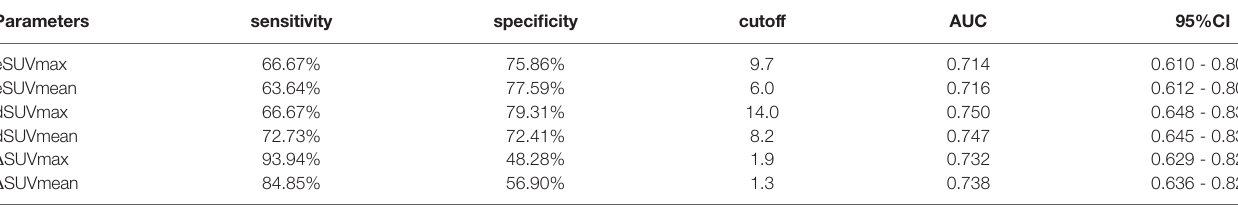
TABLE 2 | ROC analysis for the metabolic parameters according to PD-L1 expression. Parameters